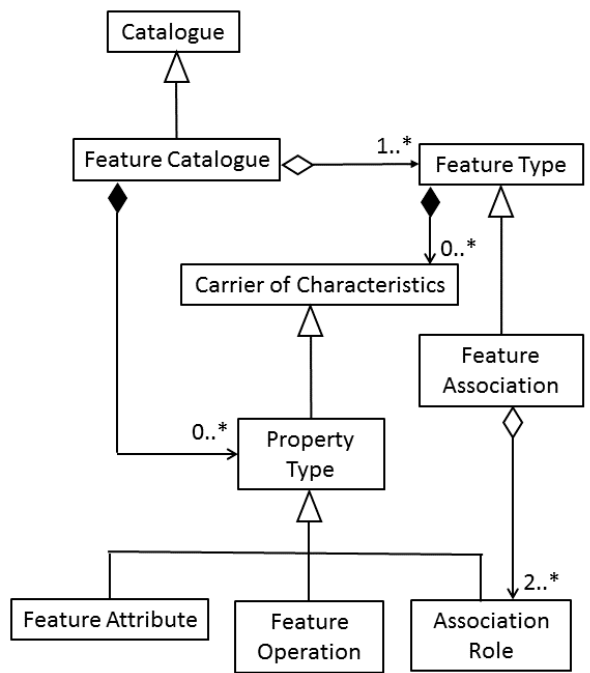
Figure 5. ISO 19110 feature catalogue UML model.